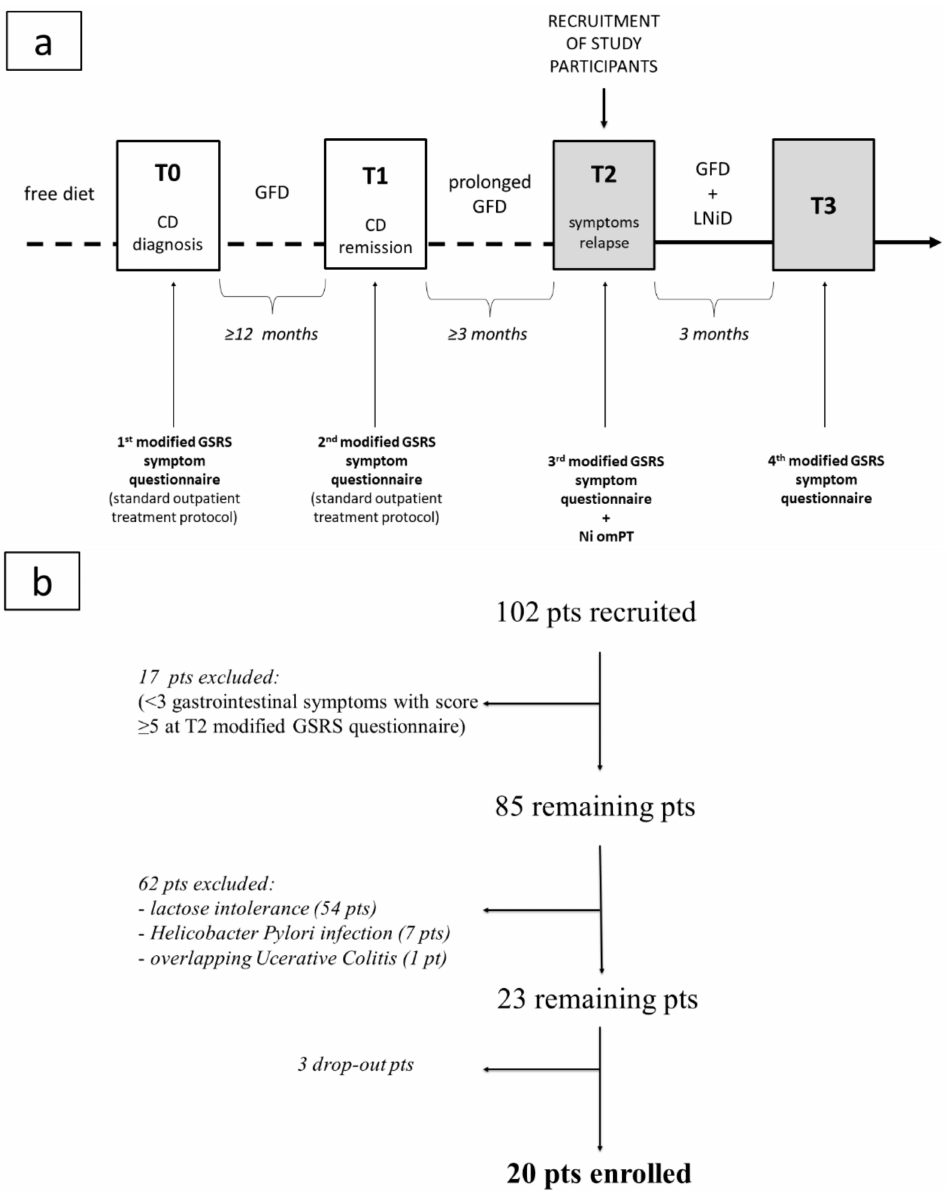
Figure 2. Flow charts of the study: ( a ) study arrangement; ( b ) patient enrollment. Legend: CD, celiac disease; GFD, gluten-free diet; GSRS, Gastrointestinal Symptom Rating Scale; LNiD, low-nickel diet; Ni omPT, nickel oral mucosa patch test; pts,